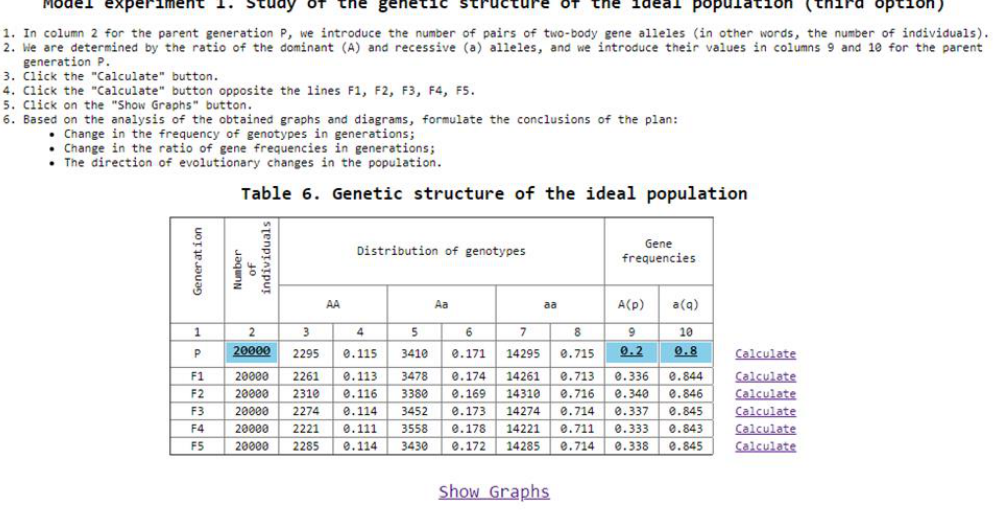
Fig.8 Results of a model experiment with a number of 200000 individuals, allele frequencies p (0,2) and q (0,8) Figure 96: Presentation of paper